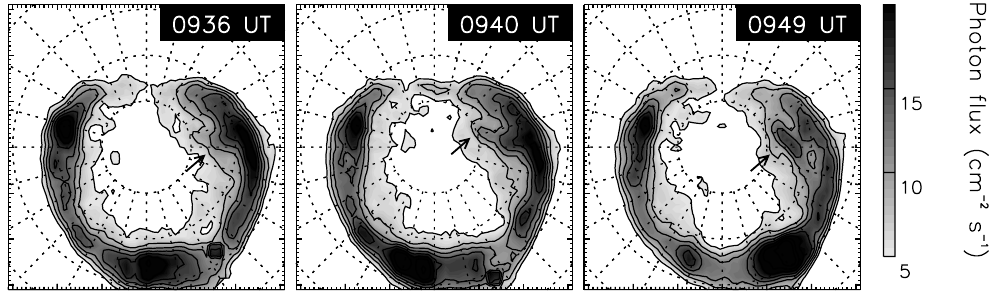
Fig. 9. Three UVI images from the growth phase of the first substorm, showing the development of a “cusp bifurcation” feature in the dawn sector.